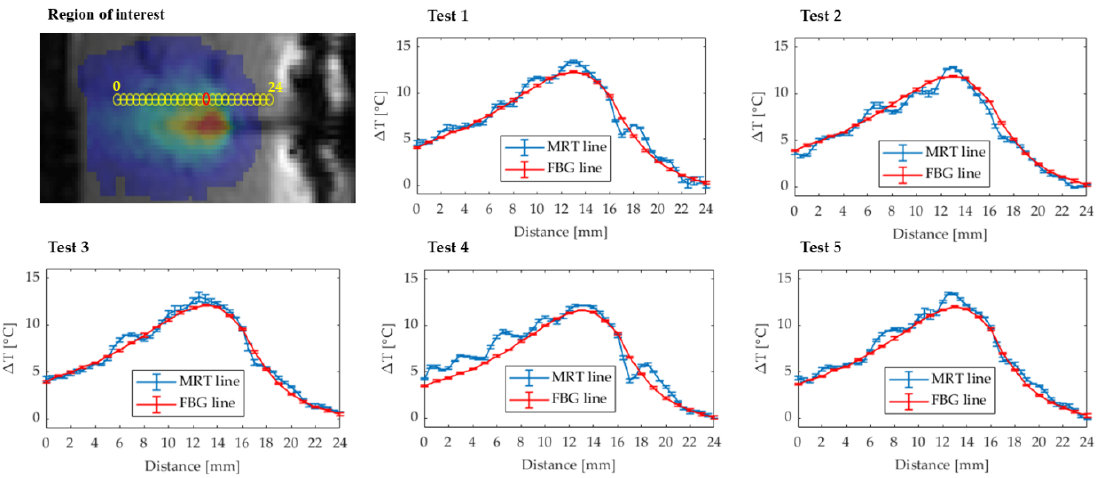
Figure 8. ROI in the MRTI images for the analysis and comparison between FBG and MRTI space temperature lines for 5 tests.